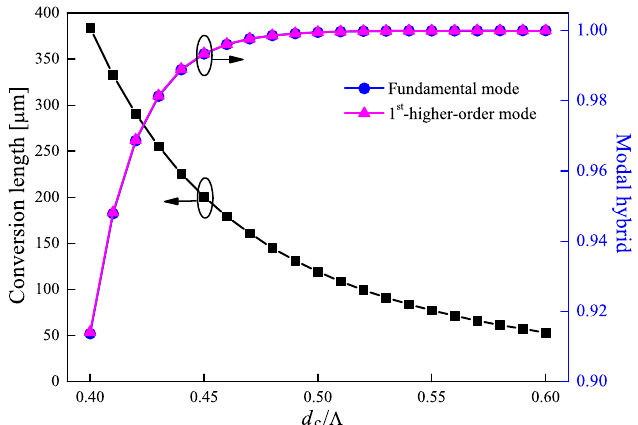
Figure 3. Conversion length as a function of d c and the corresponding modal hybrids of fundamental and 1st-higher-order modes at λ = 1.55 µ m.